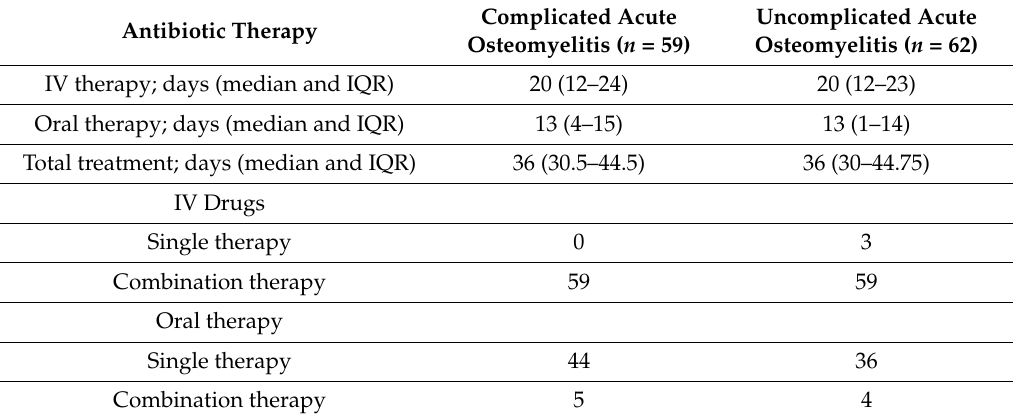
Table 3. Antibiotic therapy in complicated and uncomplicated acute